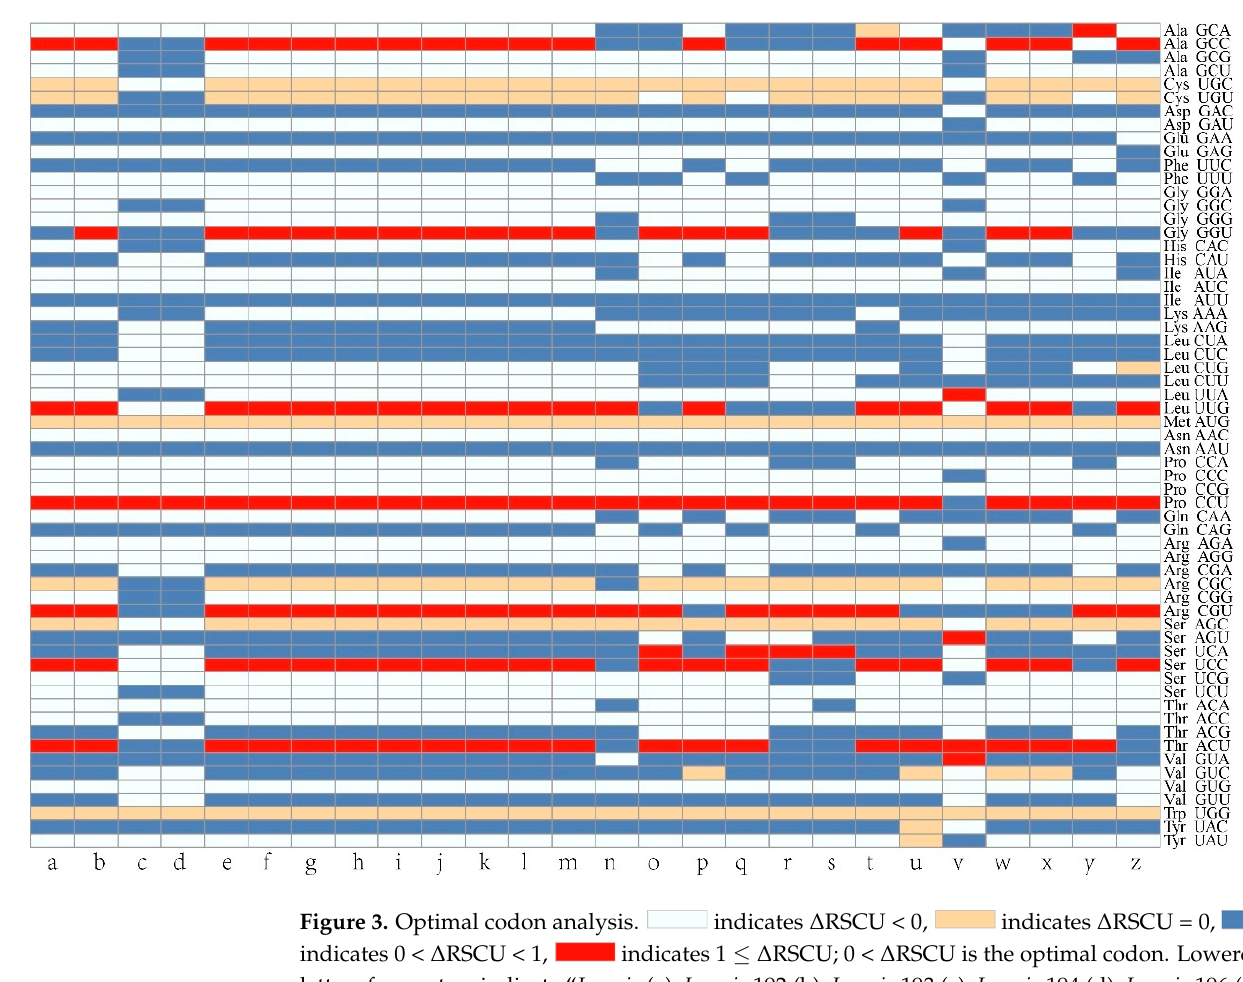
Figure 3. Optimal codon analysis. indicates Δ RSCU < 0, indicates Δ RSCU = 0, indicates 0 < Δ RSCU < 1, indicates 1 ≤ Δ RSCU; 0 < Δ RSCU is the optimal codon. Lowercase letters from a to z indicate “ J. regia (a), J. regia 192 (b), J. regia 193 (c), J. regia 194 (d), J. regia 196 (e), J. regia 197 (f), J. regia 198 (g), J. regia 199 (h), J. regia 200 (i), J. regia 201 (j), J. regia 202 (k), J. mandshurica (l), J. hopeiensis (m), P. stenoptera (n), P. macroptera (o), P. hupehensis (p), P. tonkinensis (q), E. hainanensis (r), E. roxburghiana (s), A. sinensis (t), C. paliurus (u), C. kweichowensis (v), C. hunanensis (w), C. illinoensis (x), C. cathayensis (y), and C. tonkinensis (z)”, respectively. Overall, the chloroplast genomes of 26 samples had between 24 and 30 optimal